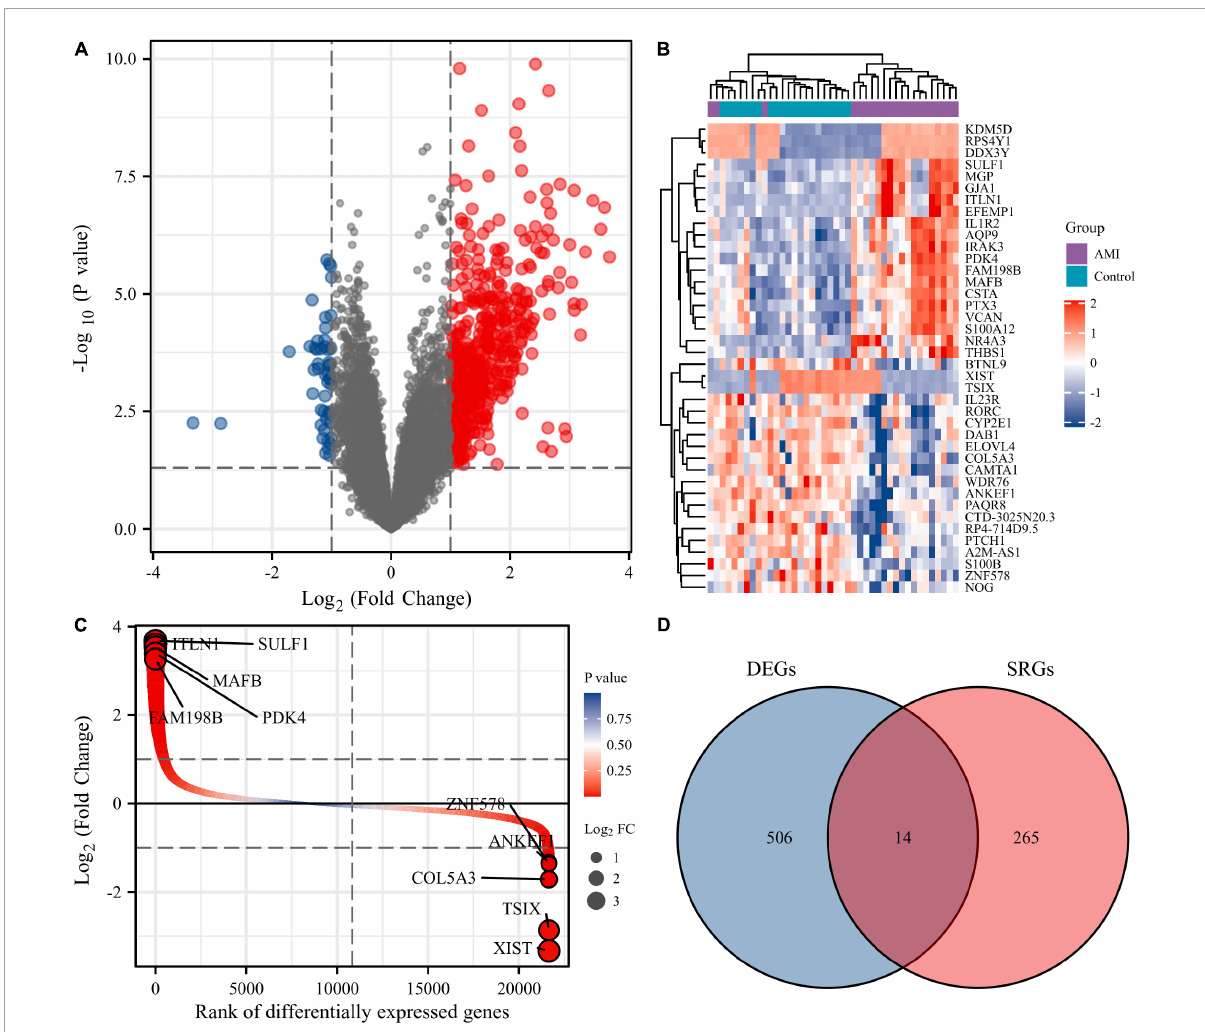
FIGURE2 Identification of DEGs and DESRGs in AMI circulating endothelial cells in the GSE66360 training set. (A) Volcano plot, (B) heatmap, and (C) difference ranking plot of DEGs between the AMI and control samples. (D) Venn diagram of overlapping genes between the GSE66360 training set and CellAge database. DEGs, differentially expressed genes; SRGs, senescence-related